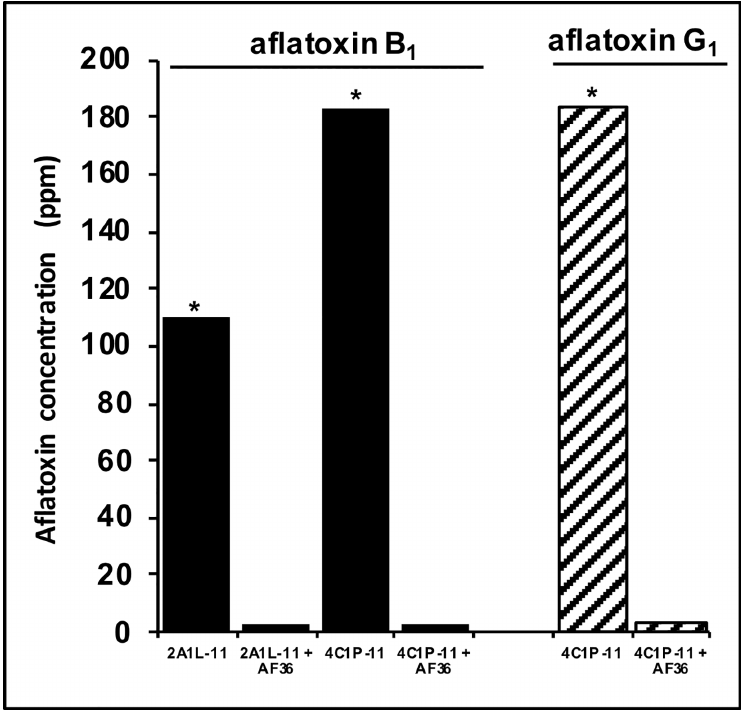
Fig 3. Ability of Aspergillusflavus AF36’s active ingredient to reduce aflatoxin accumulation in viable almonds when co-inoculated with toxigenic A . flavus 2A1L-11 or A . parasiticus 4C1P-11 isolates. Both toxigenic isolates